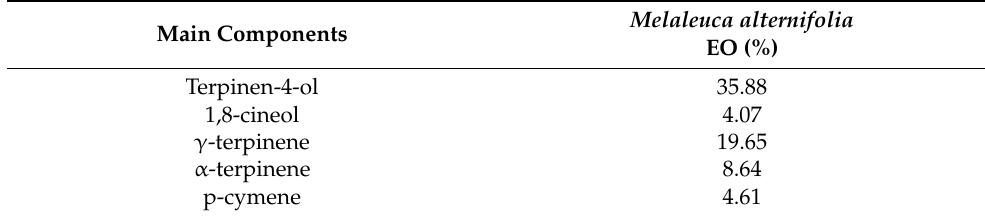
Table 1. Phytochemical composition of Melaleuca alternifolia essential oil (tea tree oil (TTO)).